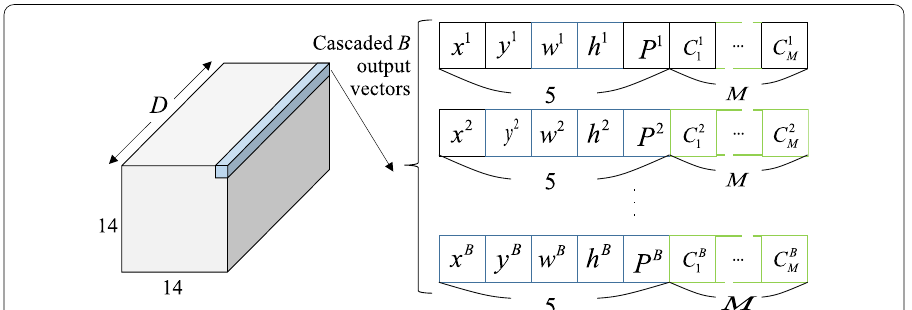
Fig. 4 Outputs of the proposed iYOLO object